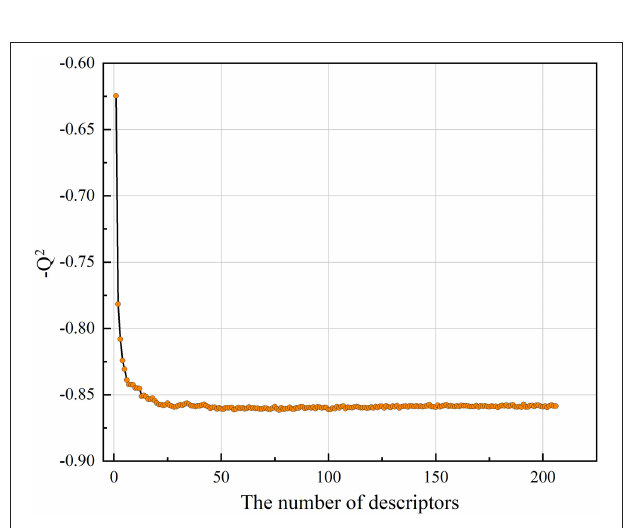
FIGURE 3 | The plot of − Q 2 vs. the number of